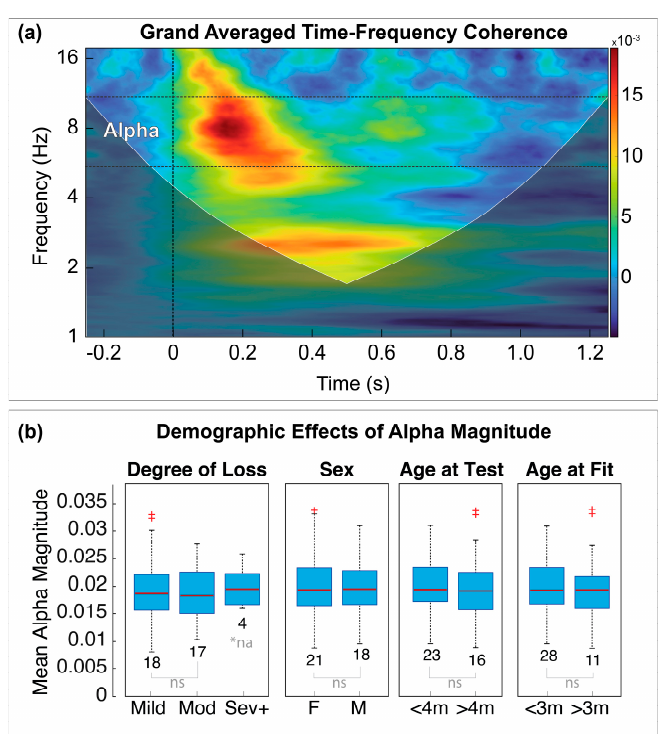
Figure 4. Time-frequency coherence and alpha band co-factor effects. ( a ) Grand averaged time- frequency coherence map of all conditions and contrasts representing the region of activation retained for the alpha band ERPs (6–12 Hz, represented by the horizontal, dotted lines). The vertical dotted line at time = 0 s represents the relative time of onset for each stimulus. The magnitude of coherence relative to the pre-stimulus baseline is represented by the color scale. The dark, shaded region in the lower portion of the figure represents time-frequency points outside of the cone-of-influence for this epoch window. ( b ) Boxplots of the distributions for mean alpha magnitudes collapsed across all trial types (standards, deviants, and contrasts) as a function of four different co-factors: Degree of loss , Sex , Age at test , and Age at (HA) fit . Statistical comparisons between each sub-group were computed separately for each co-factor ( ns = not significant, p > 0.05), *na = not assessed). + signifies points that are outside of the interquartile range. For the following co-factors: degree of hearing loss, age at test, and age at hearing aid fit two points that were outside of the interquartile range, represented by two ‘+’ stacked